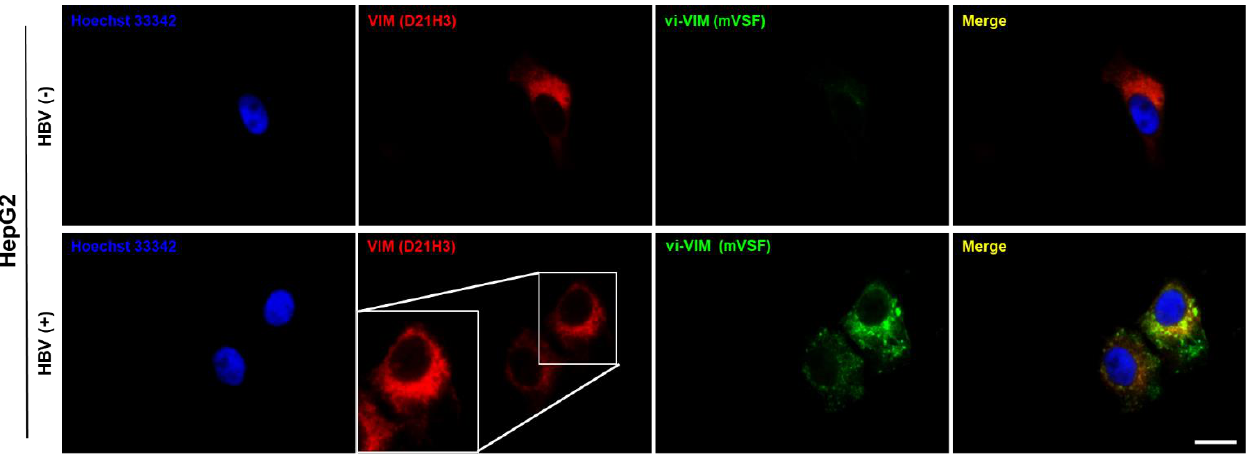
Figure 3. vi-VIM is strongly induced by HBV after infection of human hepatoma cells. HepG2 cells were infected with 50 µL of precipitated HBV derived from the supernatant of HepG2.2.15 cells. Changes in intracellular VIM (red color) and vi-VIM (green color) were detected 4 h pi by immunocytochemistry staining with D21H3 or mVSF antibodies, respectively. Merging of both stains (yellow color) indicated a perinuclear colocalization of intracellular VIM and vi-VIM. Staining with Hoechst 33,342 was used to detect cell nuclei (blue